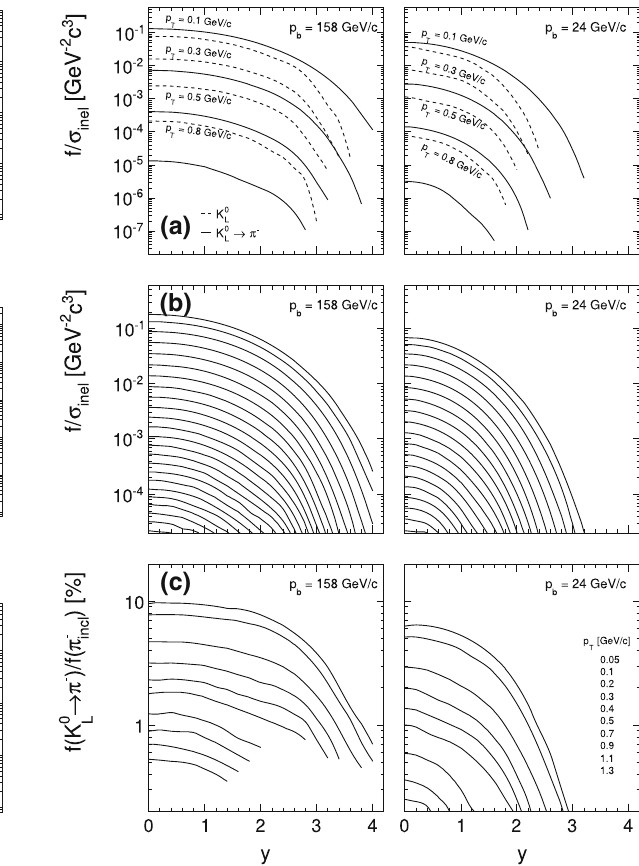
Fig. 18 a dn / dx F as a function of x F , b d σ/ dp 2 and c dn / dy as a function of rapidity for p beam = 158 and 24 GeV/c. The full lines correspond to the π − yields for the sum of the three decay channels, the broken lines to the parent particle K 0